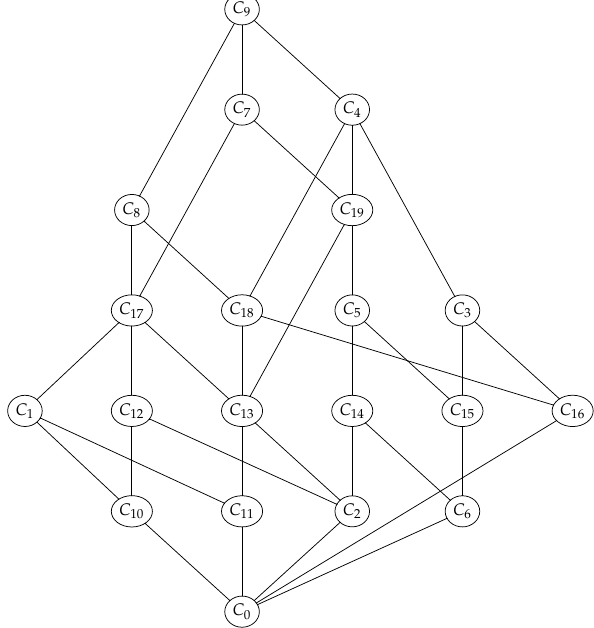
Figure 4. Left-sided complete lattice. Table 4. Meet-irreducible elements of left-sided context and their generated